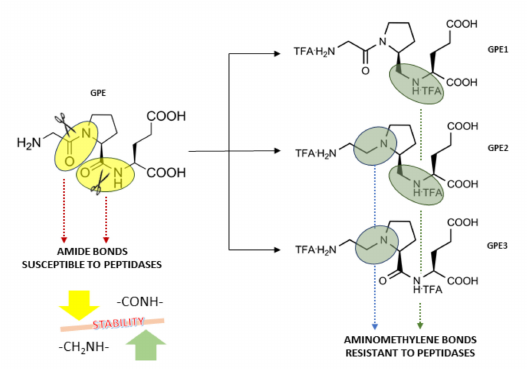
Figure 1. Design and development of GPEs peptidomimetics starting from native